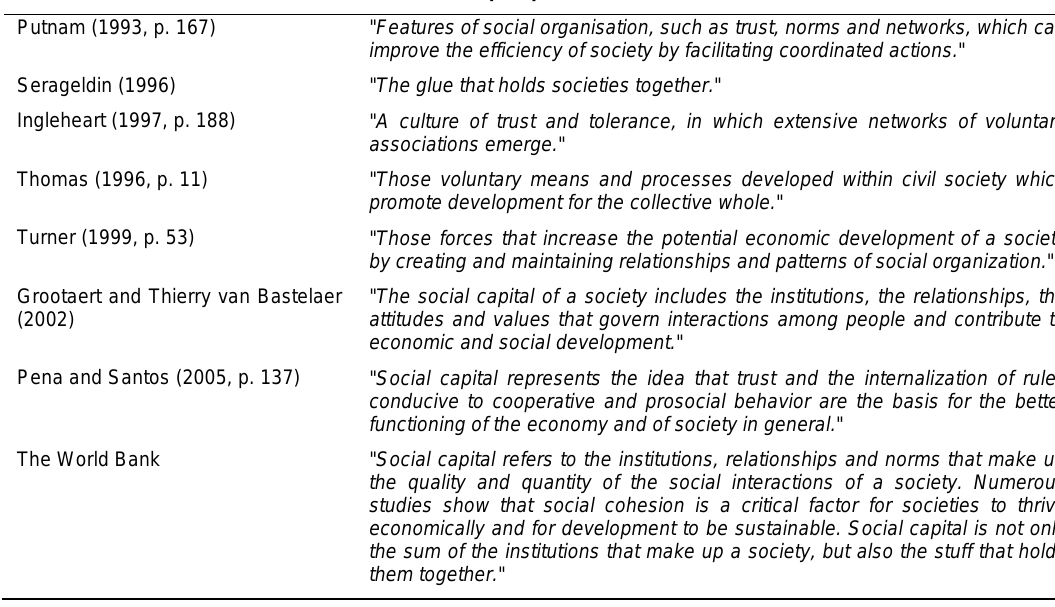
Table 3 . Definitions of social capital in the macrosocial